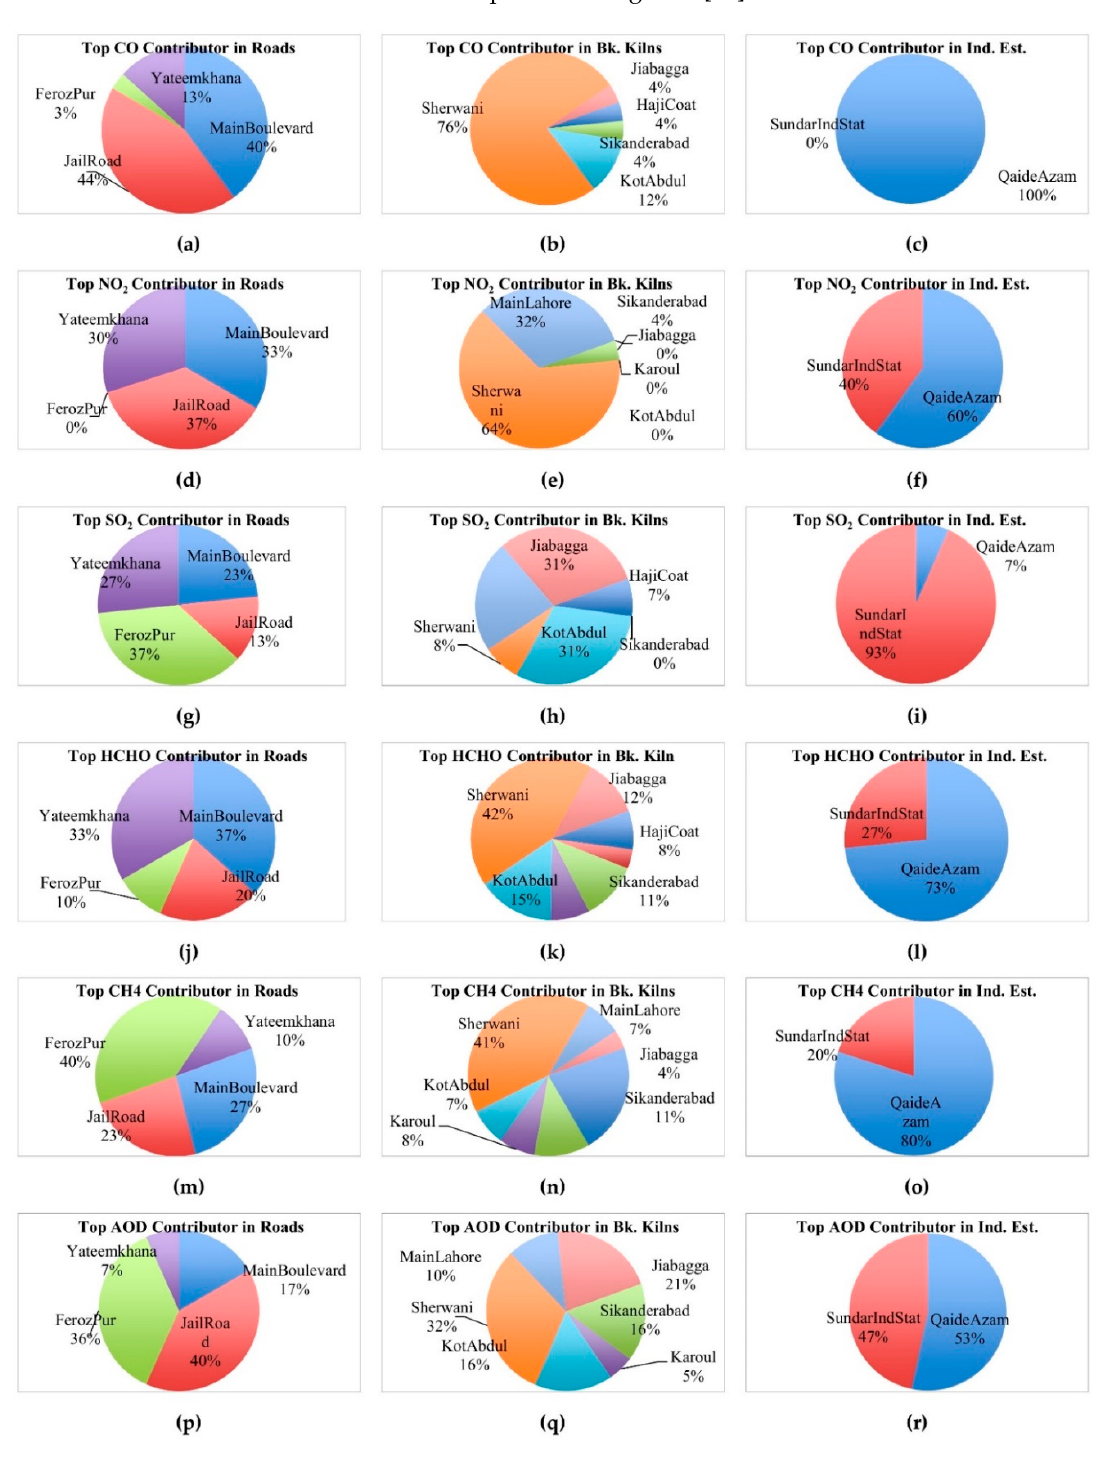
Figure 5. The top contributor of specific pollutants within various economic activities. The top contributor of ( a ) CO in Roads ( b ) CO in Brick kilns ( c ) CO in Industrial Estates ( d ) NO 2 in Roads ( e ) NO 2 in Brick kilns ( f ) NO 2 in Industrial Estates ( g ) SO 2 in Roads ( h ) SO 2 in Brick kilns ( i ) SO 2 in Industrial Estates( j ) HCHO in Roads ( k ) HCHO in Brick kilns ( l ) HCHO in Industrial Estates ( m ) CH 4 in Roads ( n ) CH 4 in Brick kilns ( o ) CH 4 in Industrial Estates( p ) AOD in Roads ( q ) AOD in Brick kilns ( r ) AOD in Industrial Estates. The CO, SO 2 , NO 2 , HCHO, and CH 4 pollutants showed variation at different sites. The top contributor of NO 2 was roads, except that Ferozpur was followed by Quaid-e-